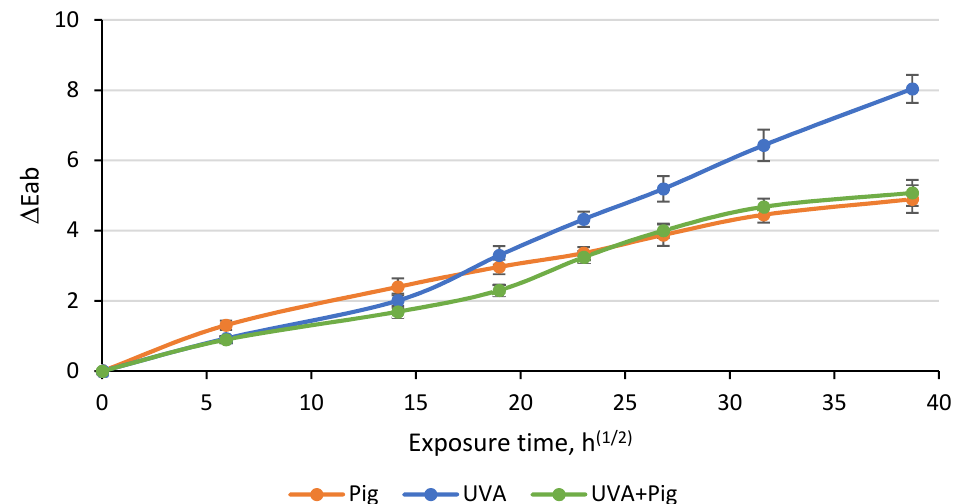
Figure 6. Discoloration of thermally modified wood with coatings containing different additives (Pig—iron oxide pigments; UVA—UV absorber) during exposure to UV irradiation. For the specimens finished with both types of coatings with the UVA additive, discoloration during the first 100 h (in the chart the unit of exposure time is a square root of an hour) was quite similar and slightly smaller than color changes detected for specimens coated with the pigmented formulation without UVA additive, implying a positive effect of the additive in delaying discoloration of TM wood. On the other